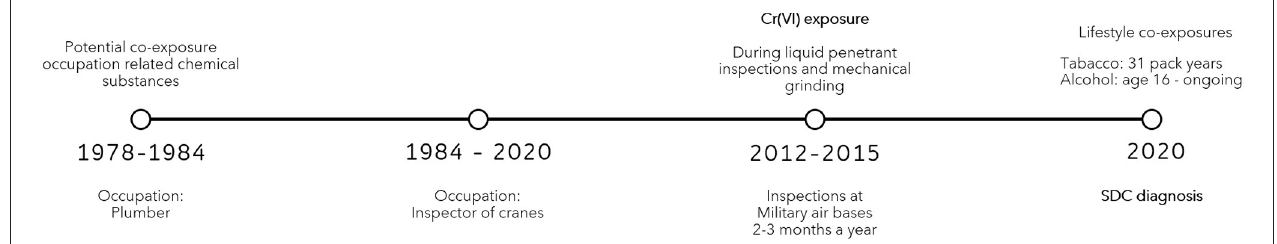
FIGURE 3 | Time-line of case report